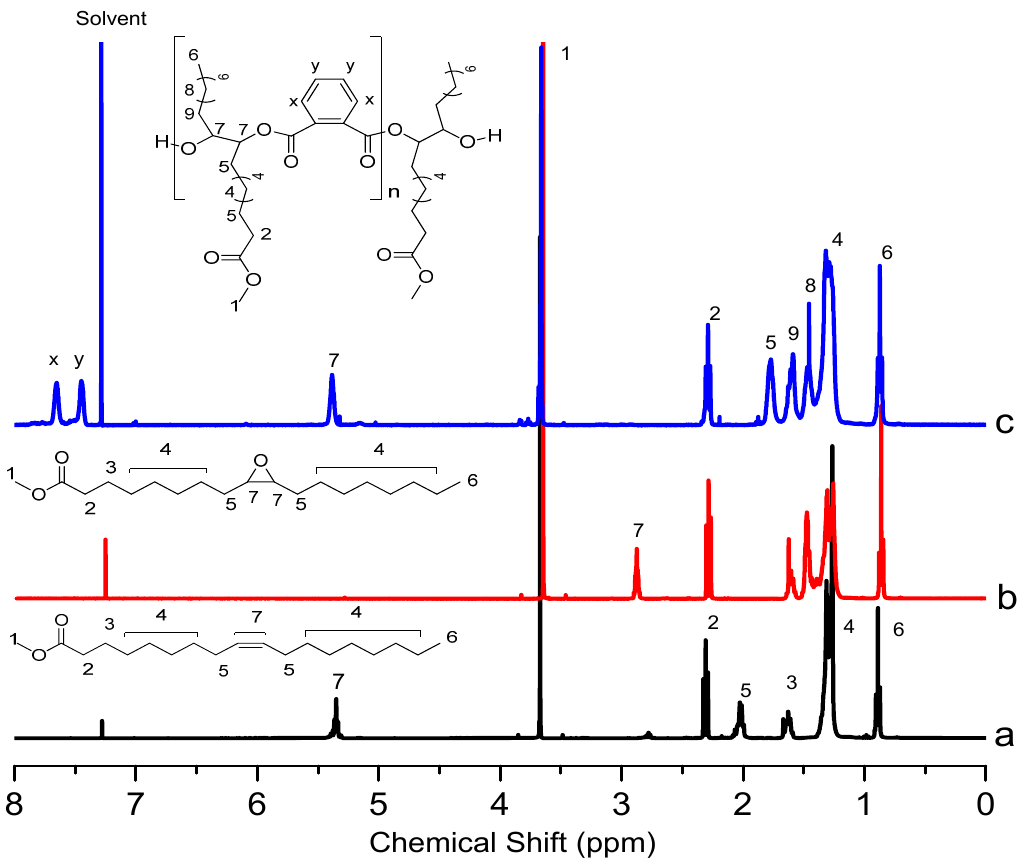
Figure 2. 1 H NMR spectra of ( a ) fatty esters; ( b ) epoxidized fatty esters and ( c ) polyesters.